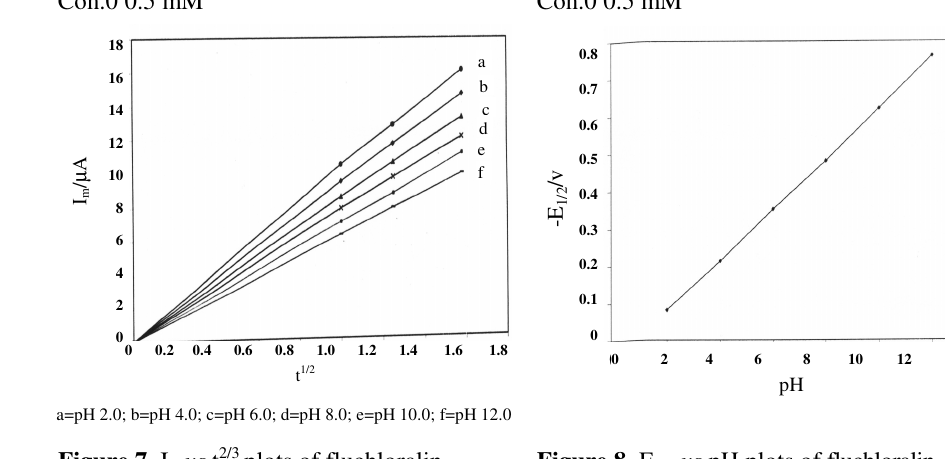
Figure 8 . E vs pH plots of fluchloralin 1/2 Con.0.5mV, Drop Time: